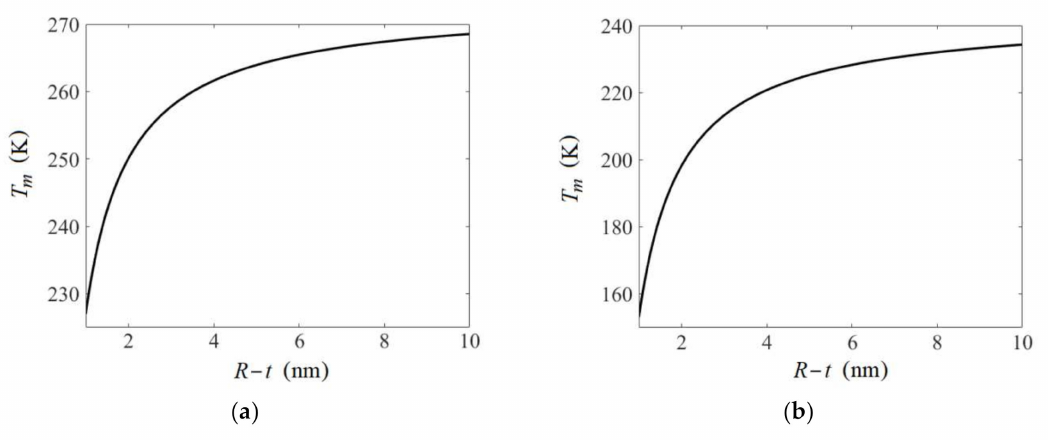
Figure 7. Melting temperature T m (K) vs. average radius r = R − t (nm) of nanoparticles of H 2 O ( a ) and n -decane ( b ) formed upon freezing of liquid confined in the